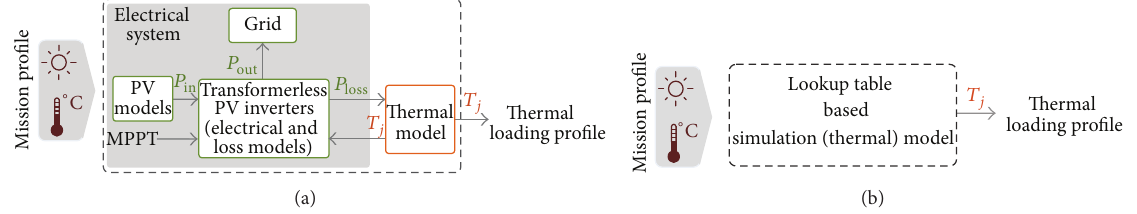
Figure 4: Approach of the mission profile translation to thermal loading at different time scales (MPPT: maximum power point tracking, 𝑇 𝑗 : junction temperature of the power devices): (a) short-term mission profiles and (b) long-term mission profiles.